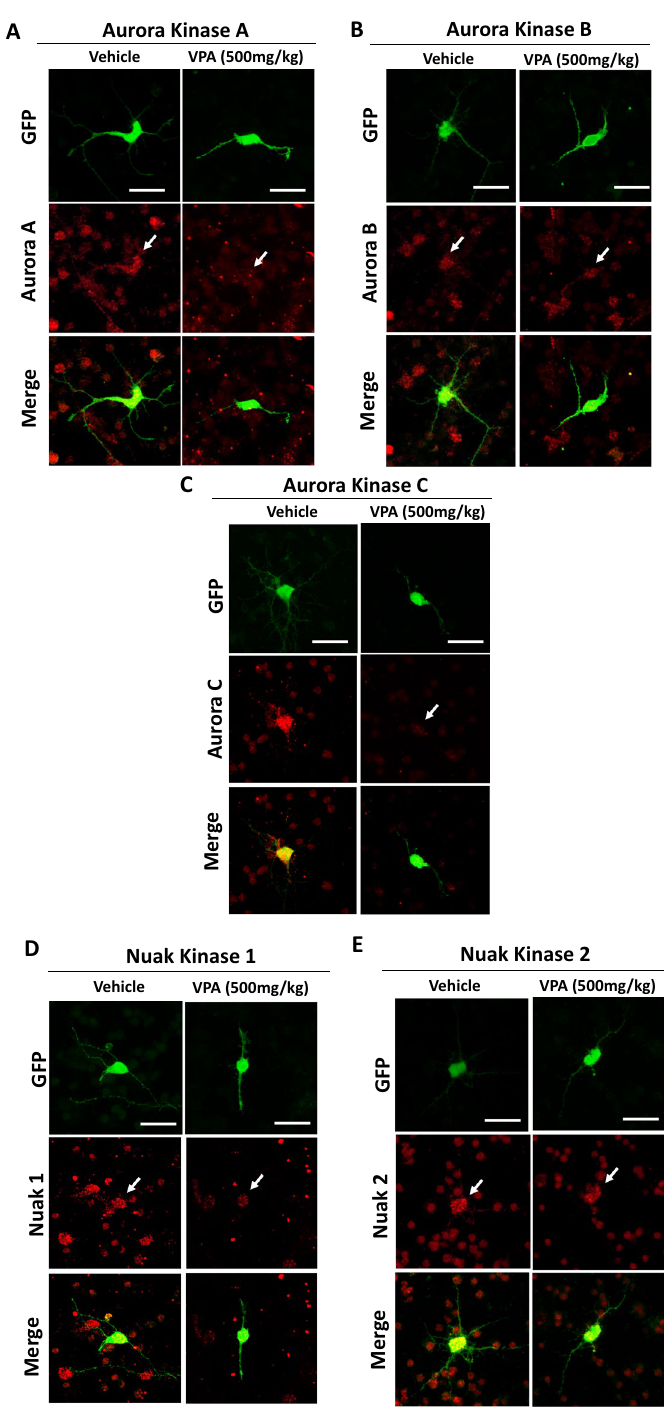
Figure 6. Expression level and pattern changes of Aurora and Nuak kinases in primary cortical neurons prepared from ASD mouse model suggest role producing in neurite formation defects. Primary cortical mouse neurons prepared from either vehicle or VPA injected dams were transfected with YFP and stained for Aurora Kinase A ( A ), Aurora Kinase B ( B ), Aurora Kinase C ( C ), Nuak Kinase 1 ( D ), and Nuak Kinase 2 ( E ), scale bars 20 µm. Note that Aurora and Nuak kinases expressed in the soma and the proximal region of neurites in the control neurons. In VPA-treated neurons, the expression of Aurora Kinase A and C as well as Nuak Kinase 1 was decreased in the soma and